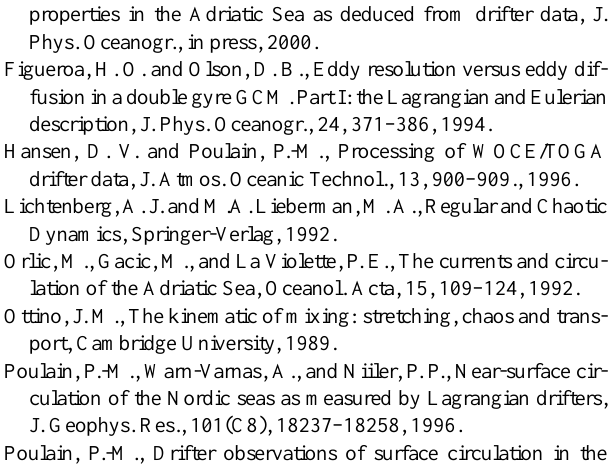
Figueroa, H. O. and Olson, D. B., Eddy resolution versus eddy